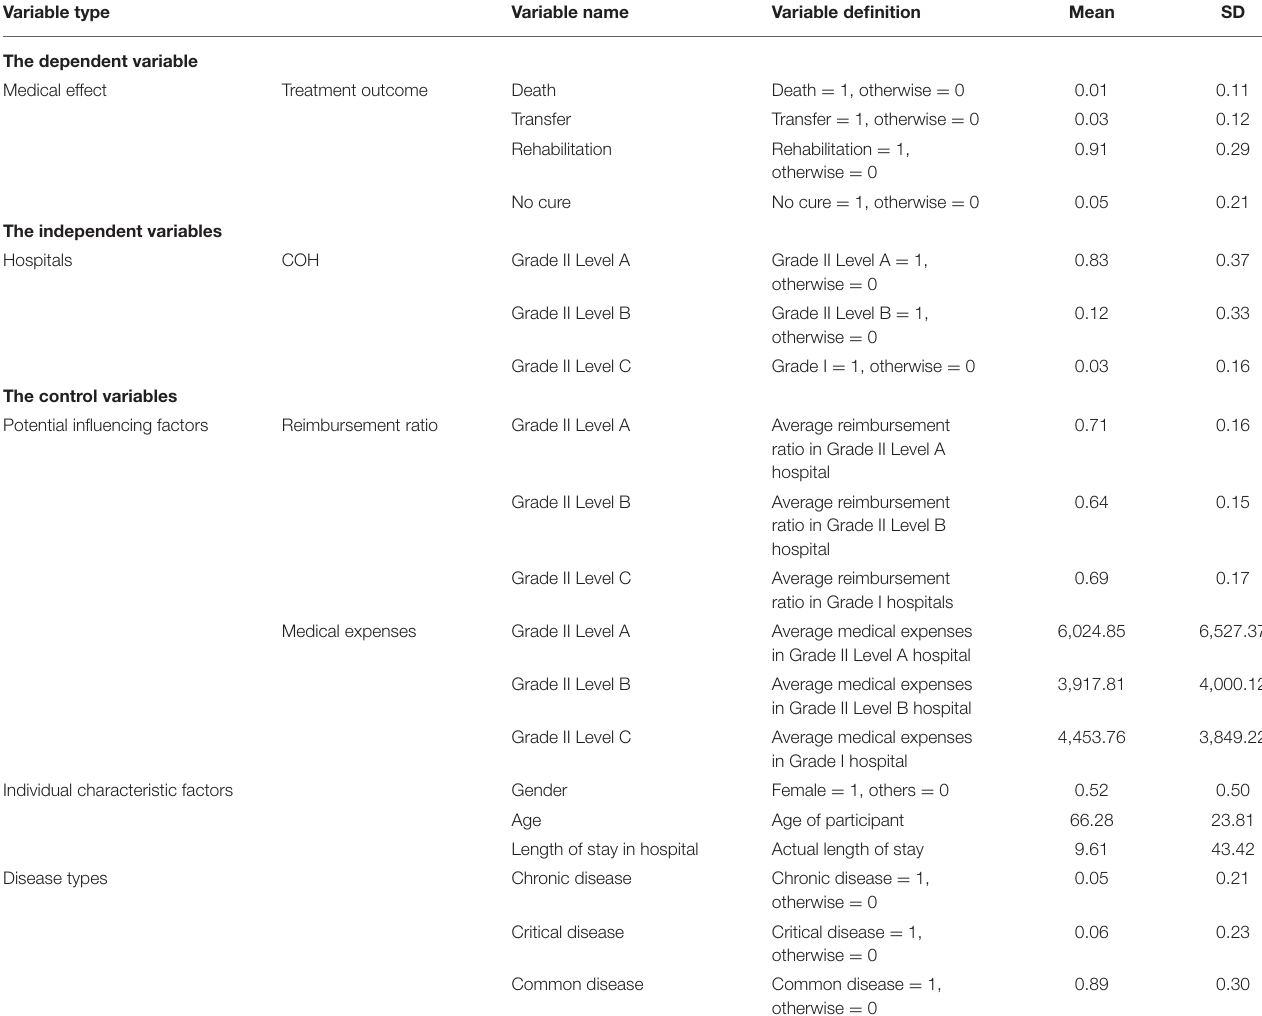
TABLE 3 | Variable definition and descriptive